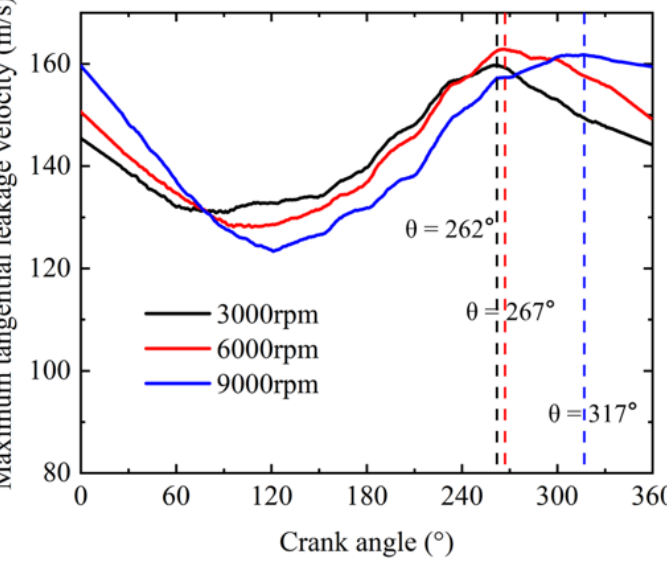
Figure 13. Variations in the maximum tangential leakage velocity with the crank angle.